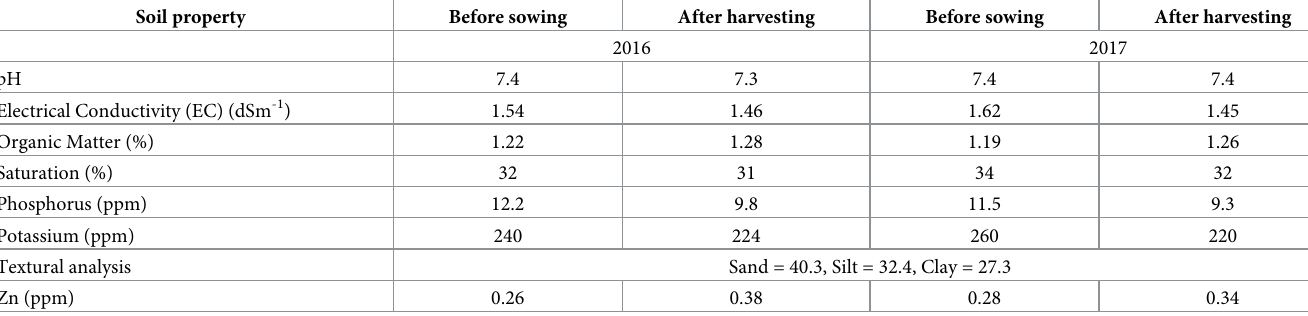
Table 1. Physicochemical properties of soil. Soil